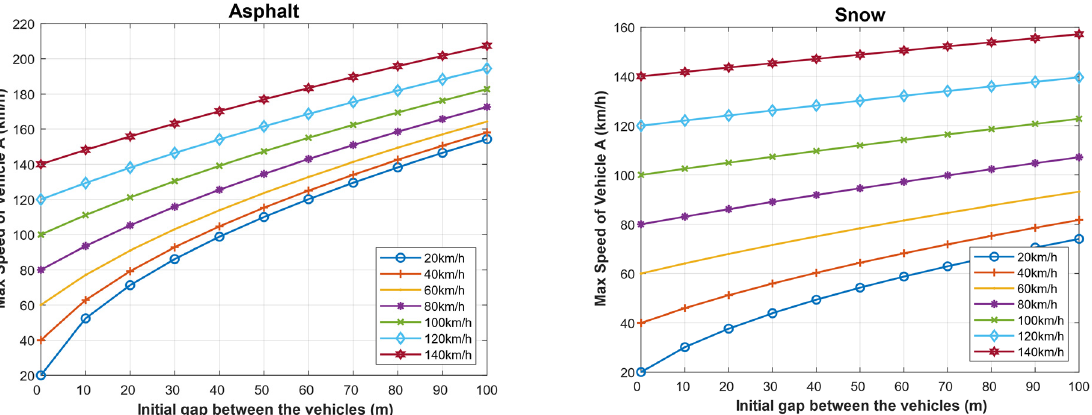
Figure 18. Maximum speed of the following vehicle for different speeds of the followed vehicle for different initial distances between the two vehicles when the following vehicle is dotted with Autonomous Emergency Braking (AEB) system ( T rA = 0